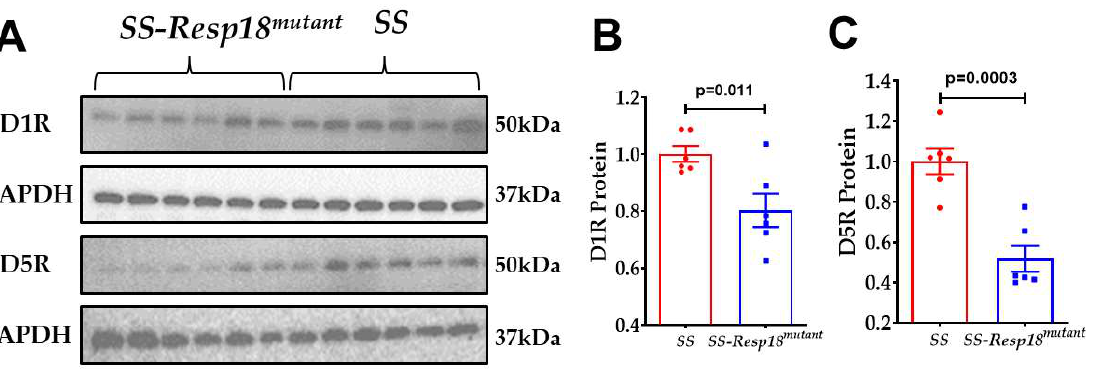
Figure 6. SS- Resp18 mutant rats have decreased renal D1-like receptor protein expression: SS and SS- Resp18 mutant rats were maintained on a high-salt diet for six weeks, and then the rat kidneys were harvested. Kidney protein lysates were immunoblotted for ( A ) D1R and D5R protein in SS and SS- Resp18 mutant rats, and ( B , C ) respective expressions were quantified by densitometry ( n = 6). Data are mean ± SEM. p = 0.011, p = 0.0003, vs. SS- Resp18 mutant rats, t -test.